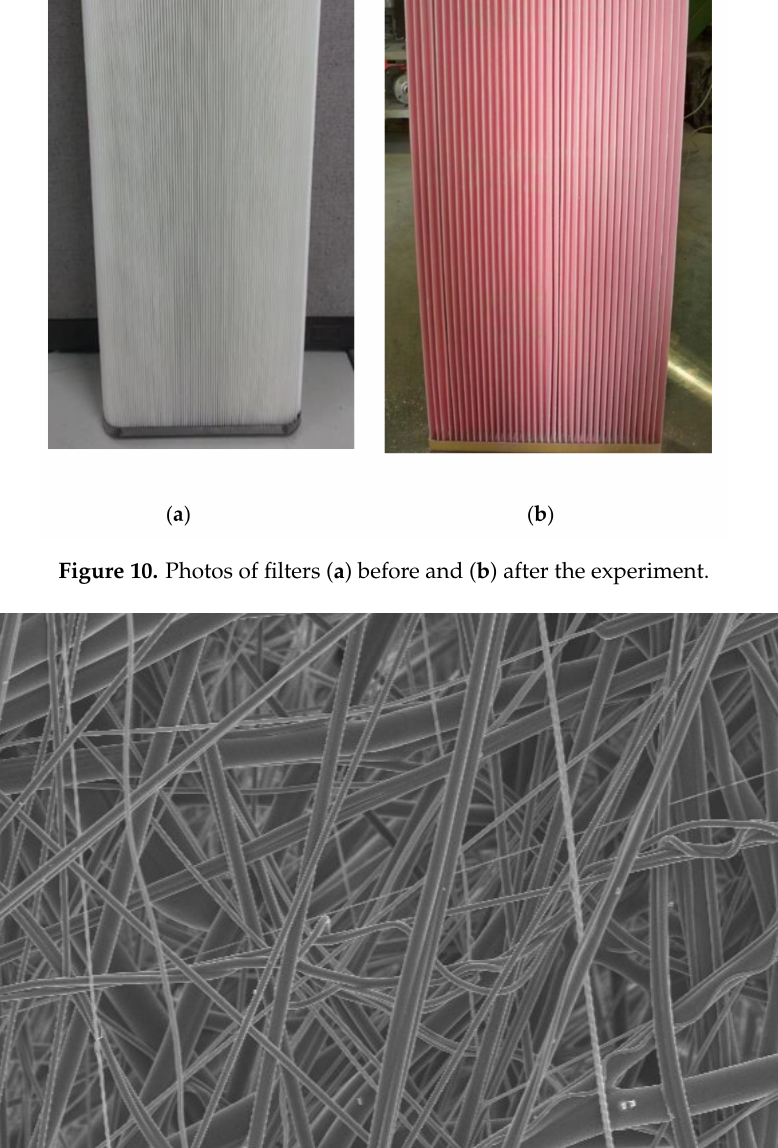
( b ) Figure 11. 1000 times magnified photos of filter media ( a ) before and ( b ) after the experiment. 4. Conclusions This research has imitated an actual painting facility for removing sticky aerosol and conducted an experiment applicable to industrial settings. The sticky aerosol has been agglomerated with calcium hydroxide to lose stickiness, collected by a filter and collected in a hopper. The experiment has been carried out with variable flow rates of 5, 10, and 15 Nm 3 /min, showing the following trend: the lower the flow rate, the longer the cleaning interval. The residual pressure drop is low, while the cleaning efficiency is high. The total and fractional collection efficiency with aerosol sizes from 0.3 to